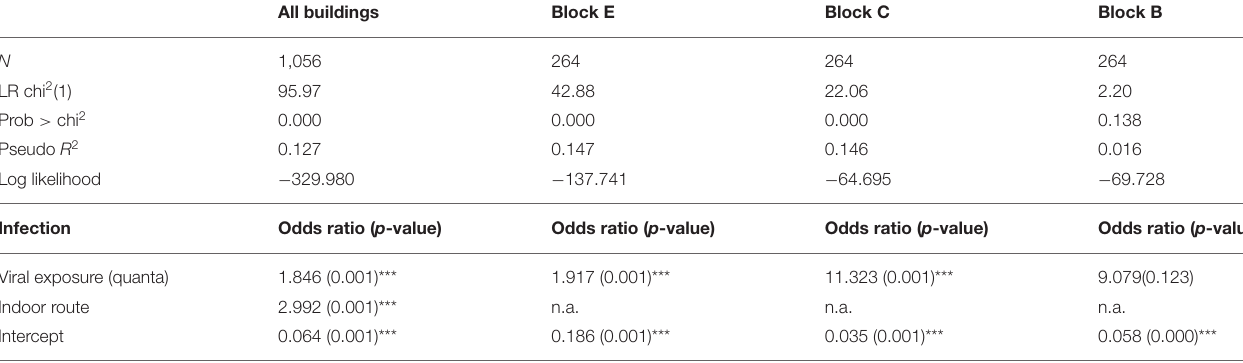
TABLE 2 | Logistic regression of the diagnosed SARS infection in apartments vs. predicted viral exposure by building. All